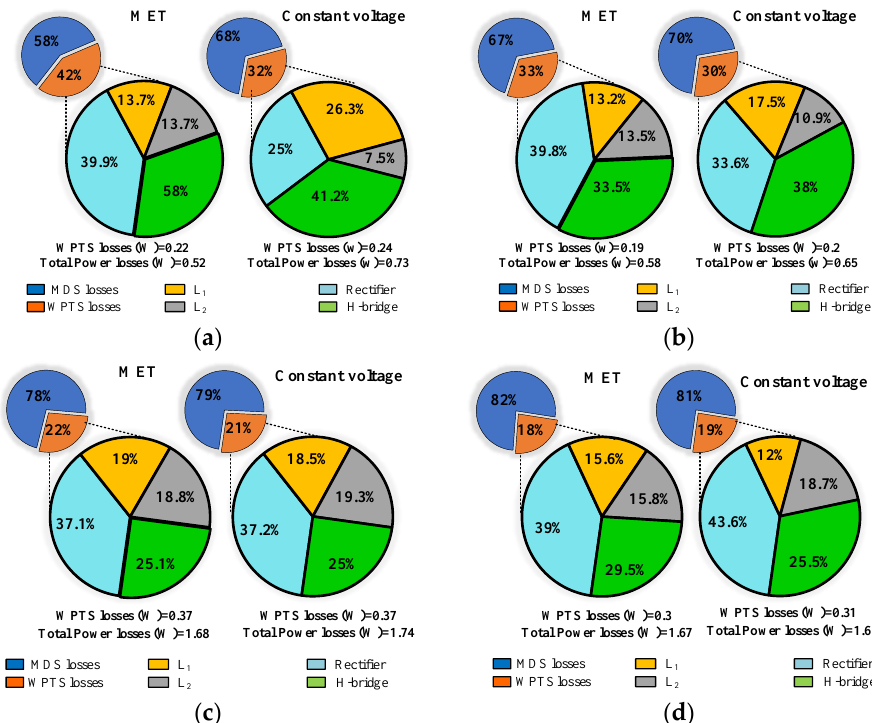
Figure 18. Efficiency analysis of the WPTS with MET and constant voltage strategies under the conditions of ( a ) K = 0.4 and P o = 2.5 W ( b ) K = 0.5 and P o = 2.5 W ( c ) K = 0.4 and P o = 5 W ( d ) K = 0.5 and P o = 5 W.